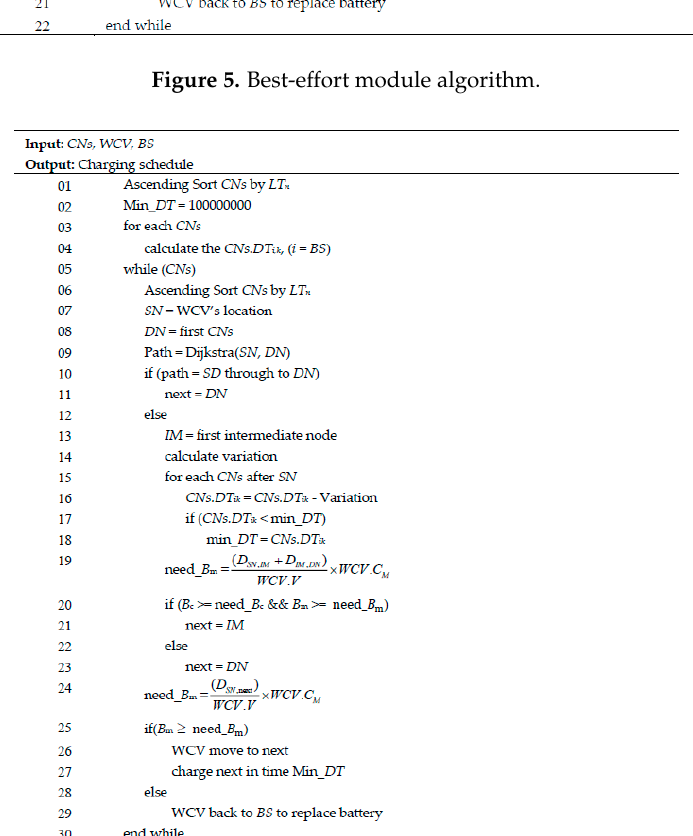
Figure 5. Best ‐ effort module algorithm.